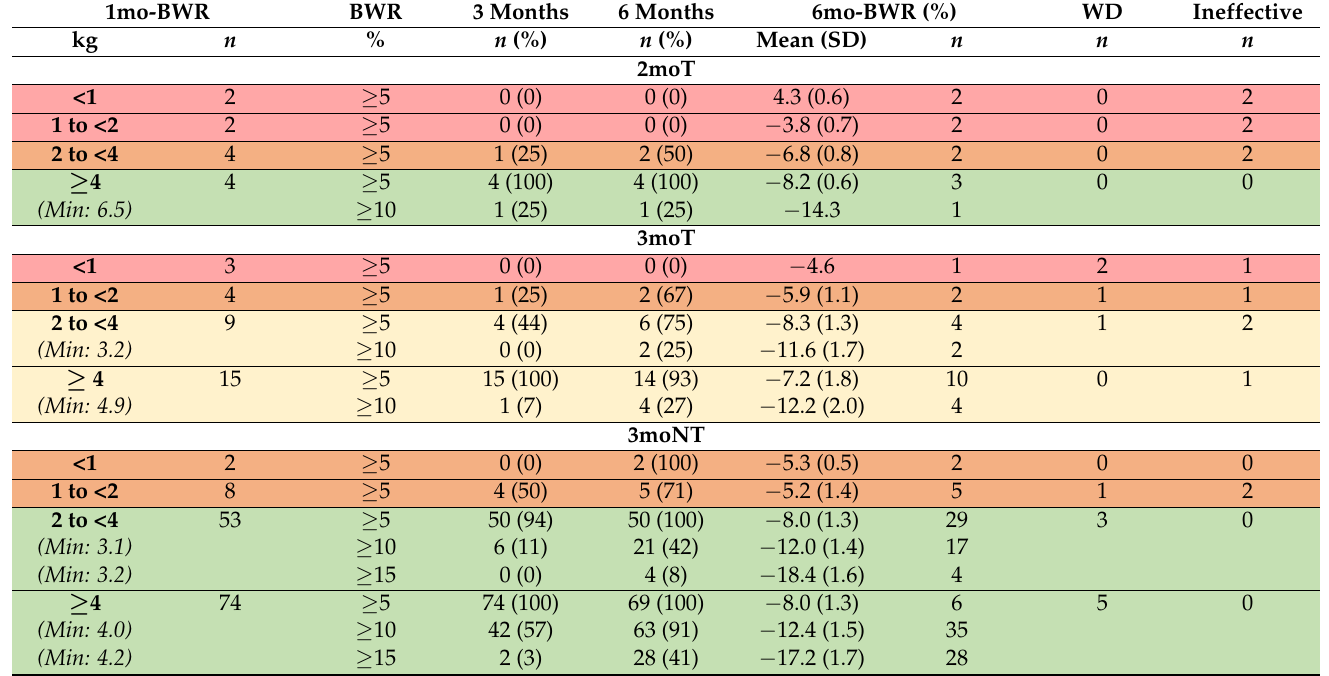
Table 2. Mazindol efficacy expectations based on early tolerance and